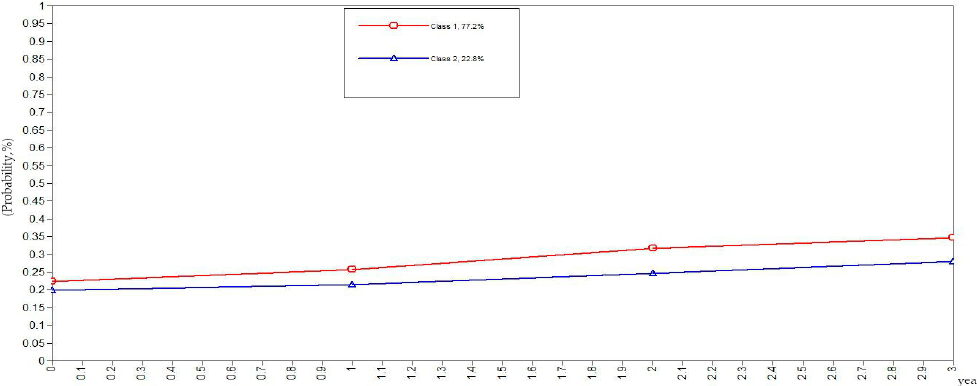
Int. J. Environ. Res. Public Health 2019 , 16 , x Figure 3. Evolution trends of the elderly with fair health behaviors. Figure 3. Evolution trends of the elderly with fair health behaviors.